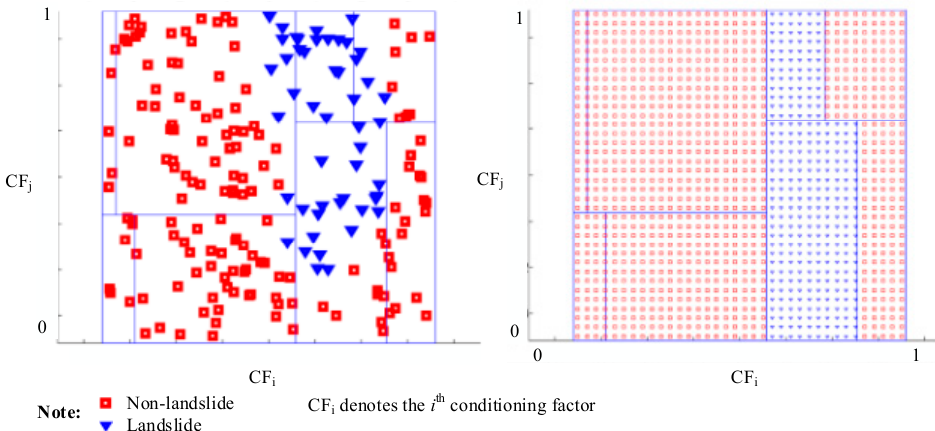
Figure 7. Illustrations of a complete training for a decision tree: ( a ) splitting thresholds and ( b ) the resulting decision border between classes.